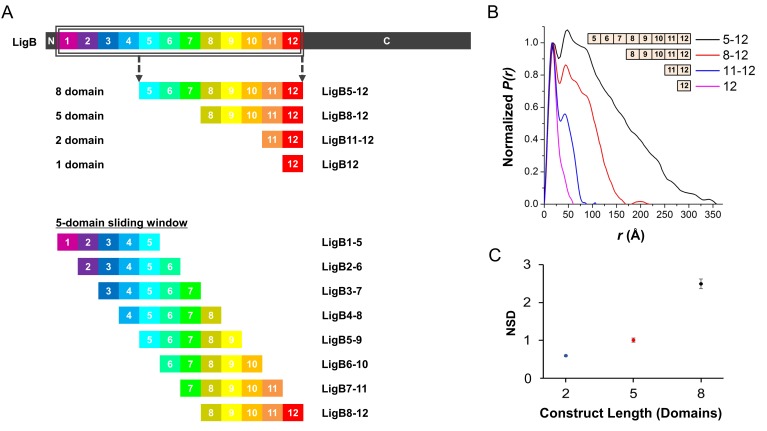
SAXS construct design.(A) Schematic of the full length LigB protein. The set of LigB constructs used to test the optimal number of Ig-like domains and the set of 5-domain constructs used for SAXS analysis. (B) SAXS atomic pair distance distributions, P(r), for 8, 5, 2, and 1 domain constructs (LigB5-12, LigB8-12, LigB11-12, and LigB12, respectively) were calculated from SAXS plots using GNOM. The P(r) was normalized at the first peak (15–20 Å) for each of the distributions. (C) The normalized spatial discrepancy (NSD) derived using the DAMAVER program suite is plotted for multi-domain LigB constructs shown in B. Error bars show S.D. for the for the 10 computed bead models. NSD values > 1 are indicative of heterogeneity in the DAMAVER models.